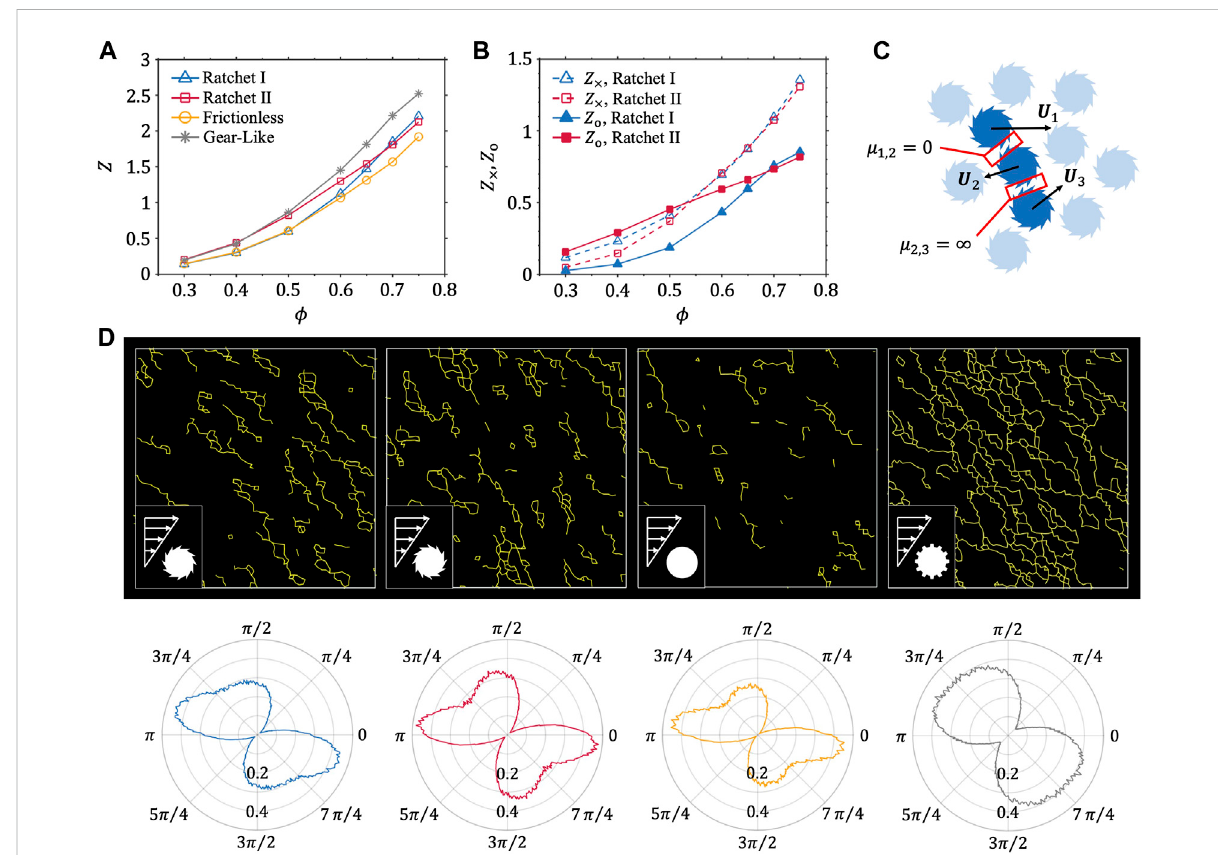
FIGURE 2 (A) Average contact number Z as a function of particle areal fraction ϕ for various particle models. (B) Average number of frictionless ( Z × ) and in fi nitely-frictional ( Z o ) contacts as a function of particle areal fraction ϕ for ratchets I and II. In (A) and (B) , error bars are not shown because they are smaller than the symbols. (C) Schematic of contact interaction between ratchets in the dense limit, where frictionless and in fi nitely-frictional contacts emerge simultaneously. Here U 1 , U 2 , and U 3 denote the velocities of three contacted particles, whereas μ 1,2 and μ 2,3 represent the staticfrictioncoef fi cientsforparticles1and2andforparticles2and3,respectively. (D) Representativesnapshotsofforcechaindistribution(top)and corresponding polar plot of the angular contact distribution (bottom) in simple shear fl ows, for particle areal fraction ϕ = 0.65 and various particle models.Insertsdenotetheparticletypeandthevelocitygradientofthesimpleshear fl ow.Theradialaxisofthepolarplotsrepresentsthedistribution probability P ( θ